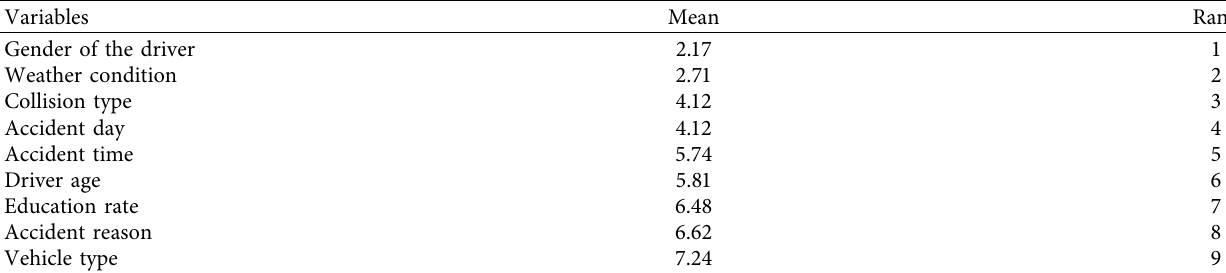
Table 4: Mean rank in the Friedman test.